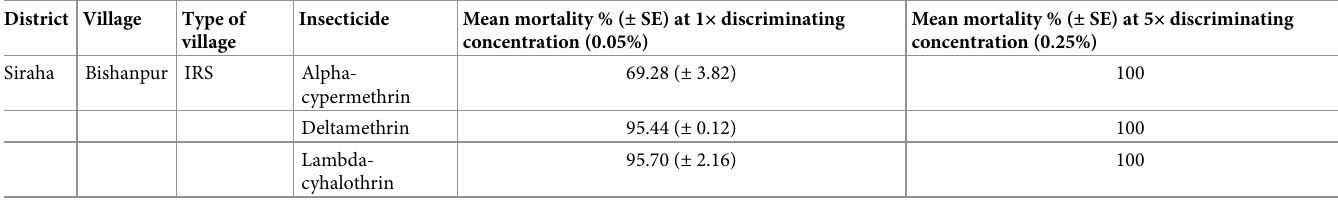
Table 4. Assessment of mean mortality percentage of P . argentipes to 5 × discriminating concentrations of pyrethroids in a selected village with resistant sand fly populations in Phase I bioassays. District Village